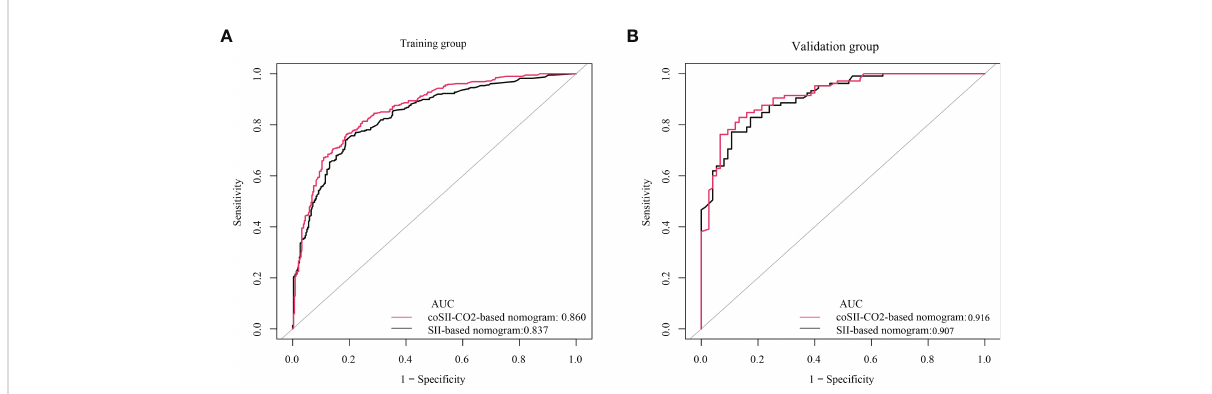
FIGURE 5 C-index based on SII and coSII-CO 2 in the training and validation groups. (A) The C-index of SII and coSII-CO 2 in the training group was 0.837 and 0.860, respectively. (B) The C-index of SII and coSII-CO 2 in the validation group was 0.907 and 0.916, respectively.